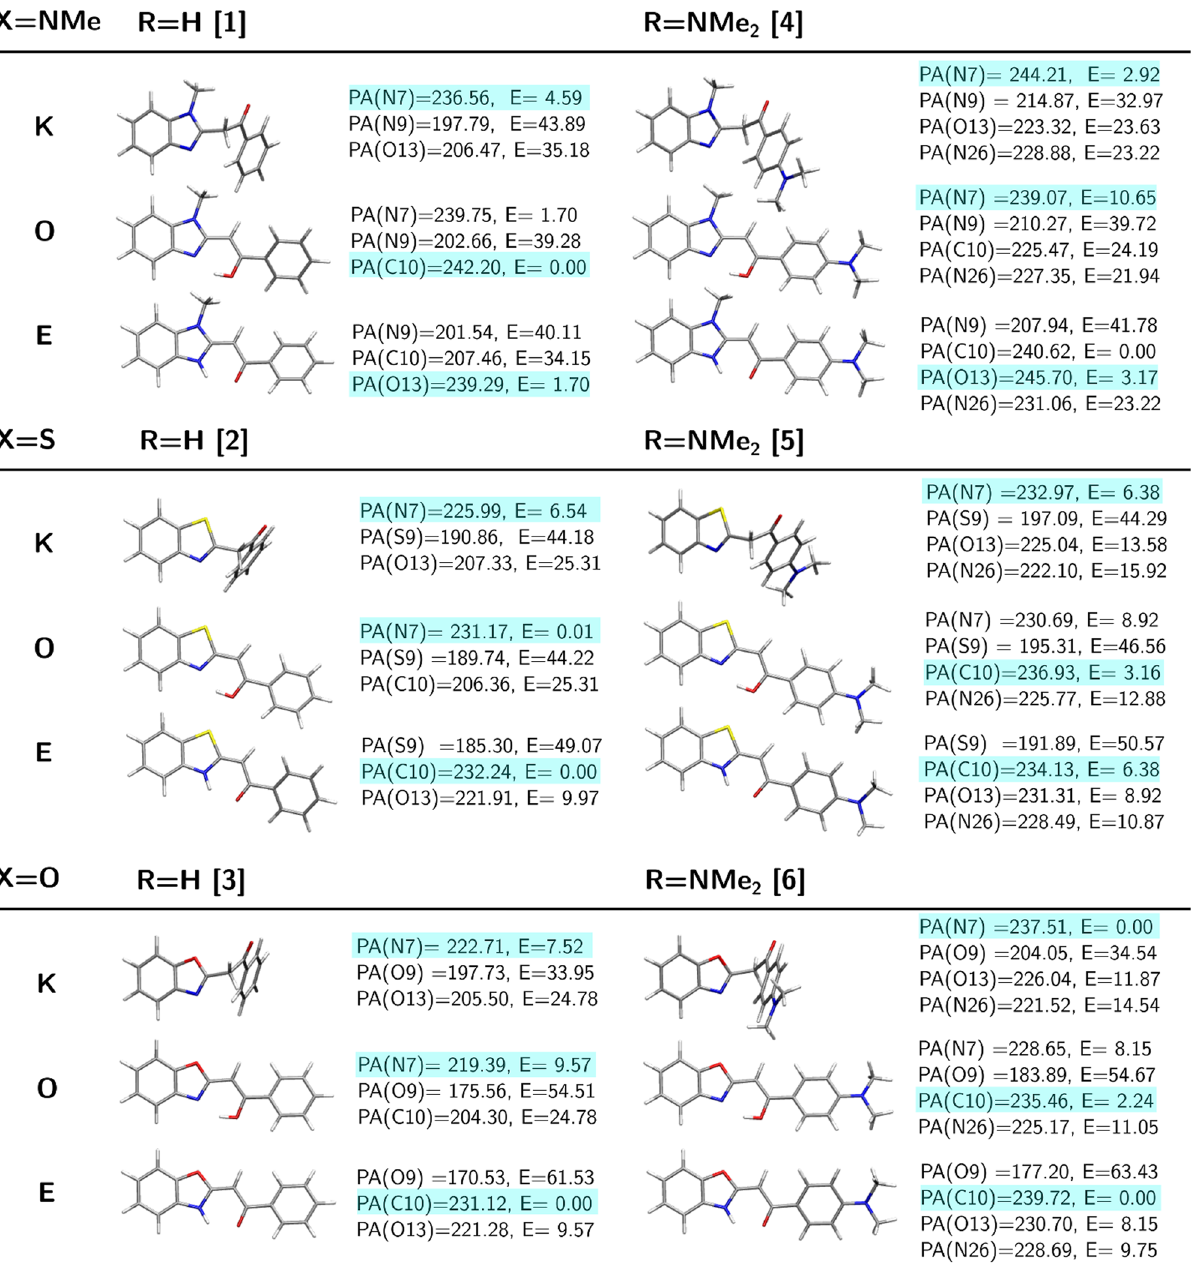
Figure 3. Proton affinities for 1 – 6 tautomers (K, O and E denote keto, enol and enamine form, respectively). PA(N) is the proton affinity at N7 protonation site, PA(O13) denotes the protonation at O13 site, PA(C10) stands for the proton affinity at C10 site, PA(X9) corresponds to the proton affinity at X9 site (where X=N,S,O) and PA(N26) is the proton affinity at the terminal dimethylamino group (in kcal/mol; definition given in text). E is the ω B97X-D/6-311++G(d,p) relative energy for protonated forms, in